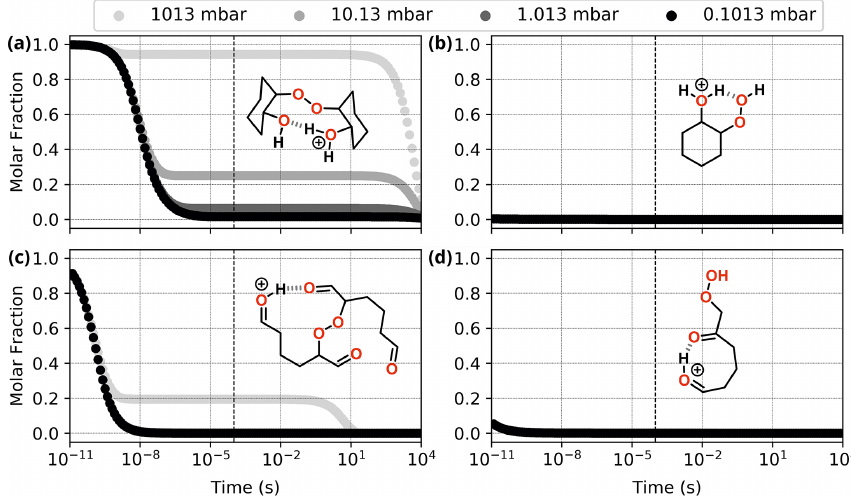
Figure 10. Reaction dynamics simulation results for the investigated ROOR (a, c) and ROOH (b, d) species derived from cyclohexene oxidation by OH radical (a, b) and O 3 (c, d) . Graphs represent the time evolution profile for reaction of initial protonated reactants at 298.15K. Dashed line indicates 100µs from the start of the